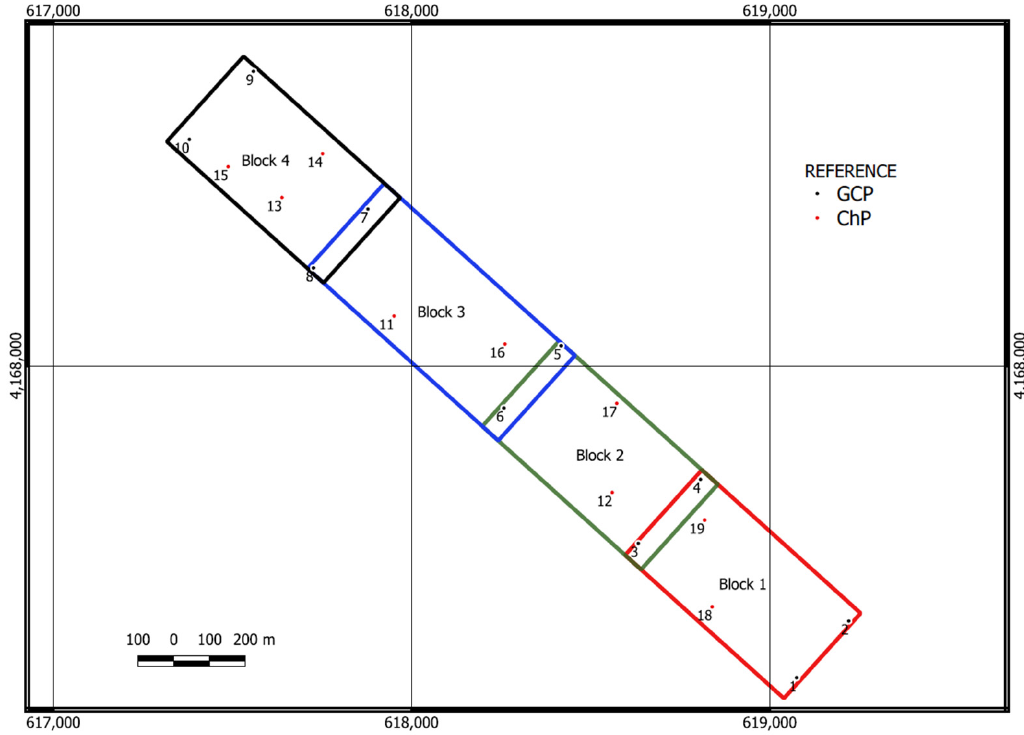
Figure 4. Location of the ten GCPs at the corners of each block and nine ChPs distributed within the blocks; the reference system is UTM 30N ETRS89.